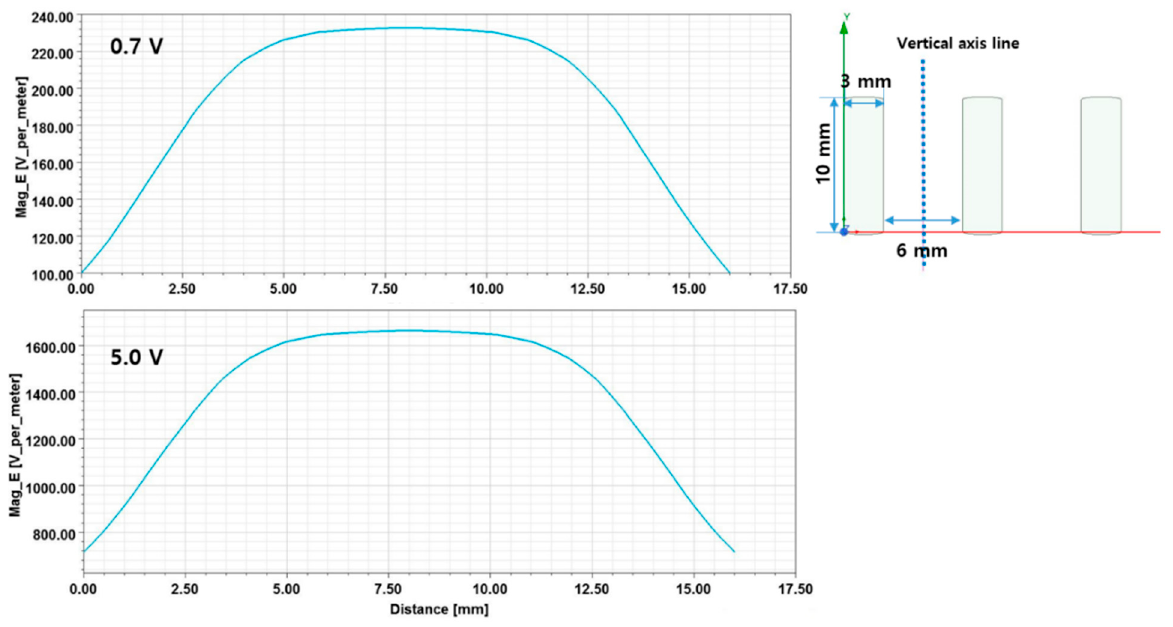
Figure 4. Plot of the magnitude of the electric field along the length of the vertical axis for the different voltage conditions.